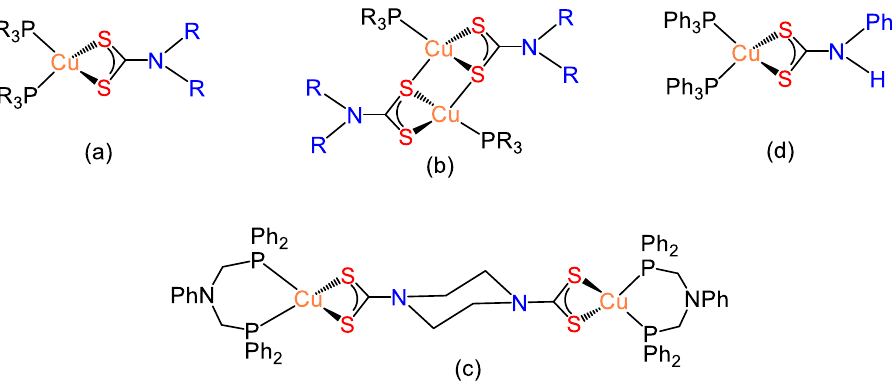
Figure 16. Line drawings of various Cu(I) phosphine-containing dithiocarbamate complexes ( a ) – ( d ).